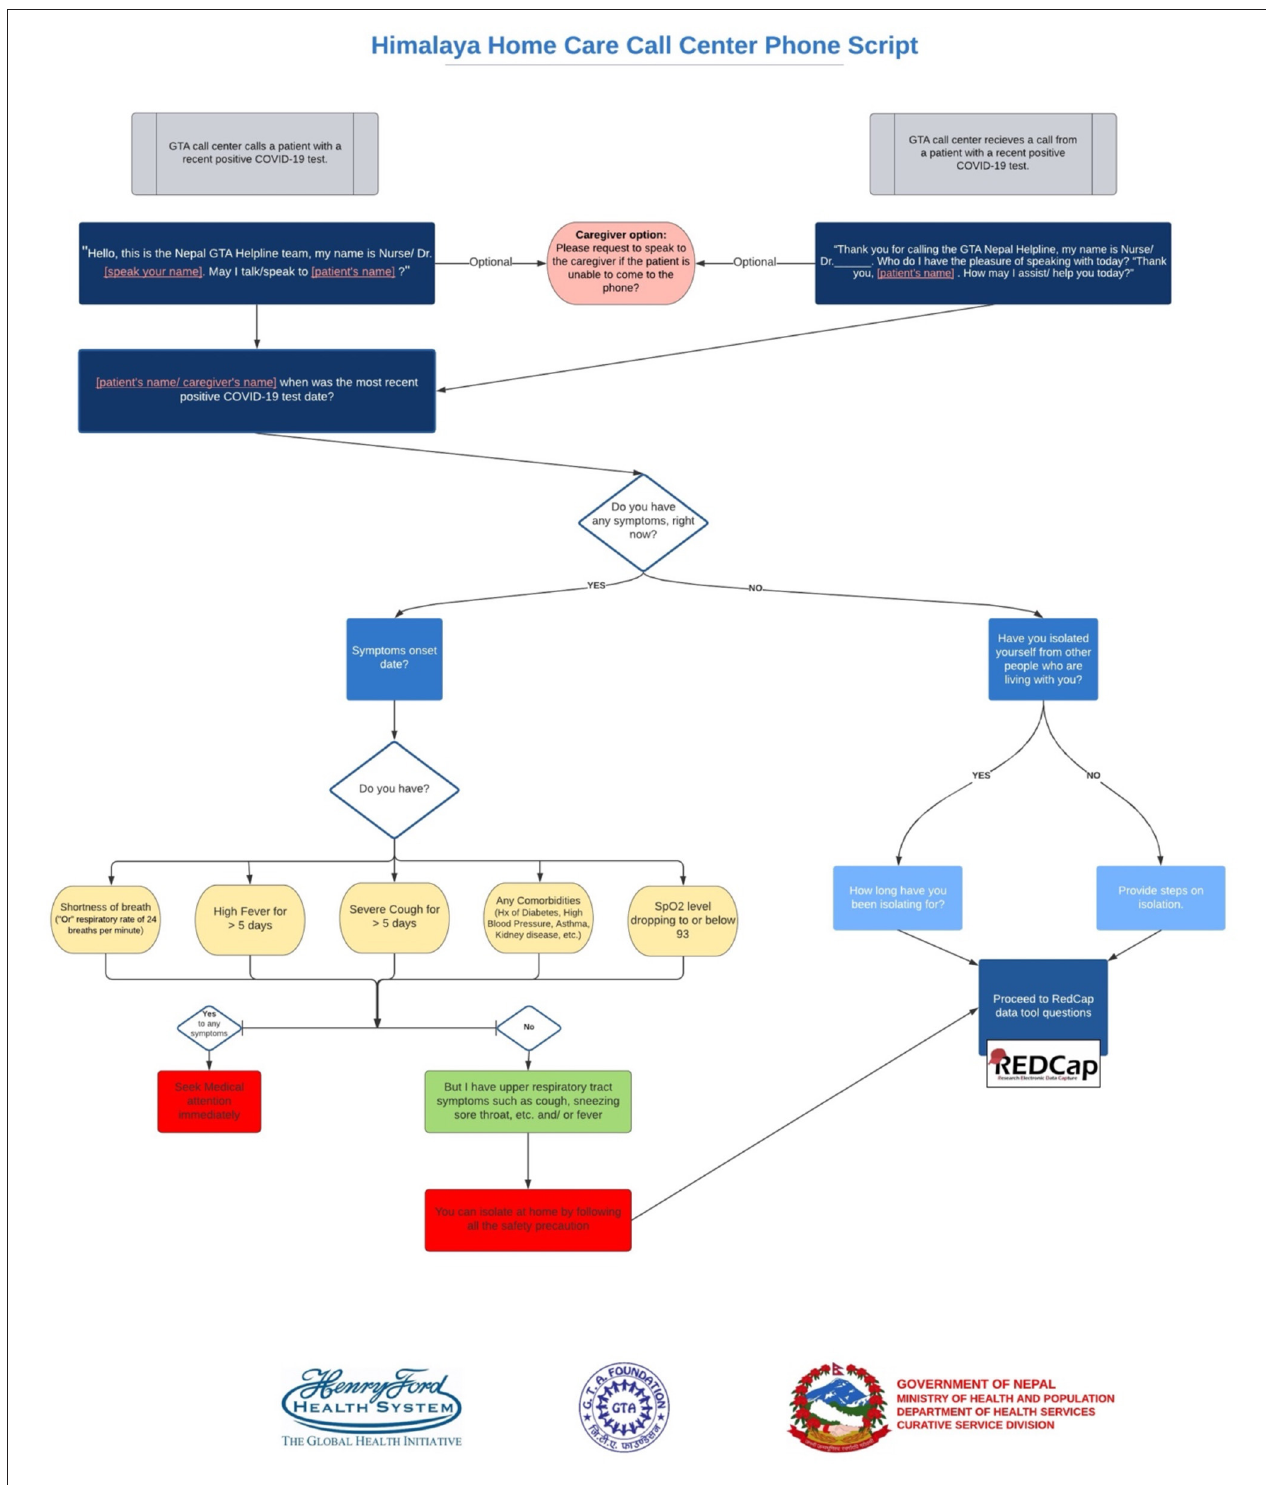
FIGURE 1 | Himalaya home care call center phone